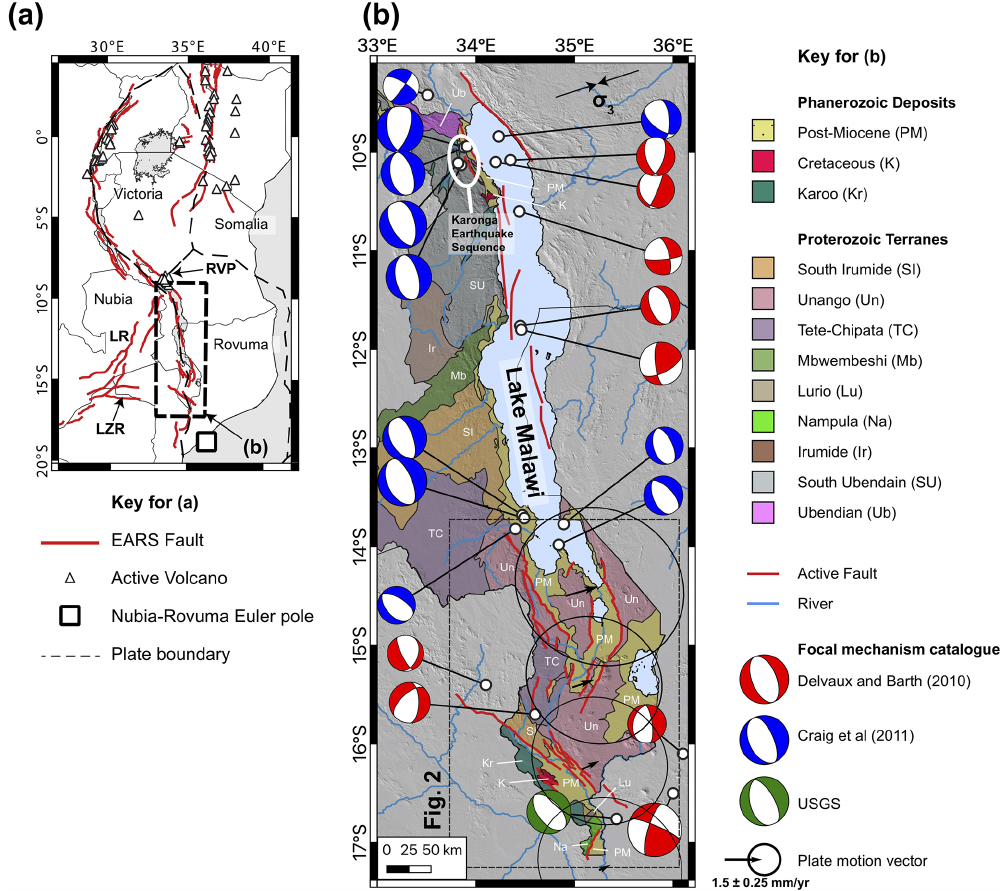
Figure 1. (a) The location of Malawi in the context of major faults in the East African Rift (Daly et al., 2020; Hodge et al., 2018a; Macgregor, 2015) and plate boundaries proposed by Saria et al. (2013). LZR represents the Lower Zambezi Rift, LR represents the Luangwa Rift, and RVP represents the Rungwe Volcanic Province. (b) A simplified geological map of Malawi, with Proterozoic terranes after Fullgraf et al. (2017). The map is underlain by the Shuttle Radar Topography Mission (SRTM) 30m digital elevation model (DEM; Sandwell et al., 2011). The extent of Fig. 2 is also shown. Active faults within this area are those included in the South Malawi Active Fault Database (SMAFD). Active faults outside this region are mapped as in panel (a) . Focal mechanisms collated from Delvaux and Barth (2010), Craig et al. (2011), and the U.S. Department of the Interior U.S. Geological Survey (2018). Minimum principal compressive stress ( σ 3 ) trend from focal mechanism stress inversion (Williams et al., 2019). Plate motion vector for central point of each basin in southern Malawi (Fig. S1) for the Nubia–Rovuma Euler pole (Saria et al., 2013), modelled using methods described in Robertson et al.